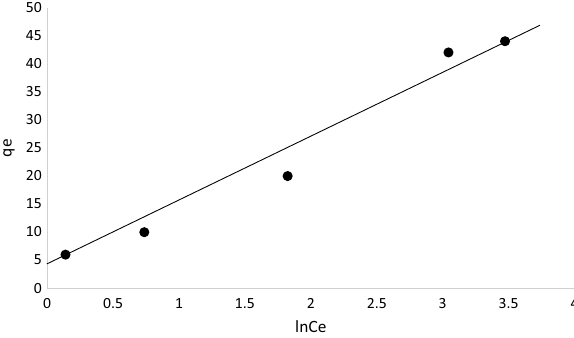
Fig. 8 Effect of temperature on the adsorption of Rh-B on AgNPs at different temperatures. 1 g/l of AgNPs in 100 ml of 50 mg/l Rh-B, 150 rpm 60 min, pH 3.4